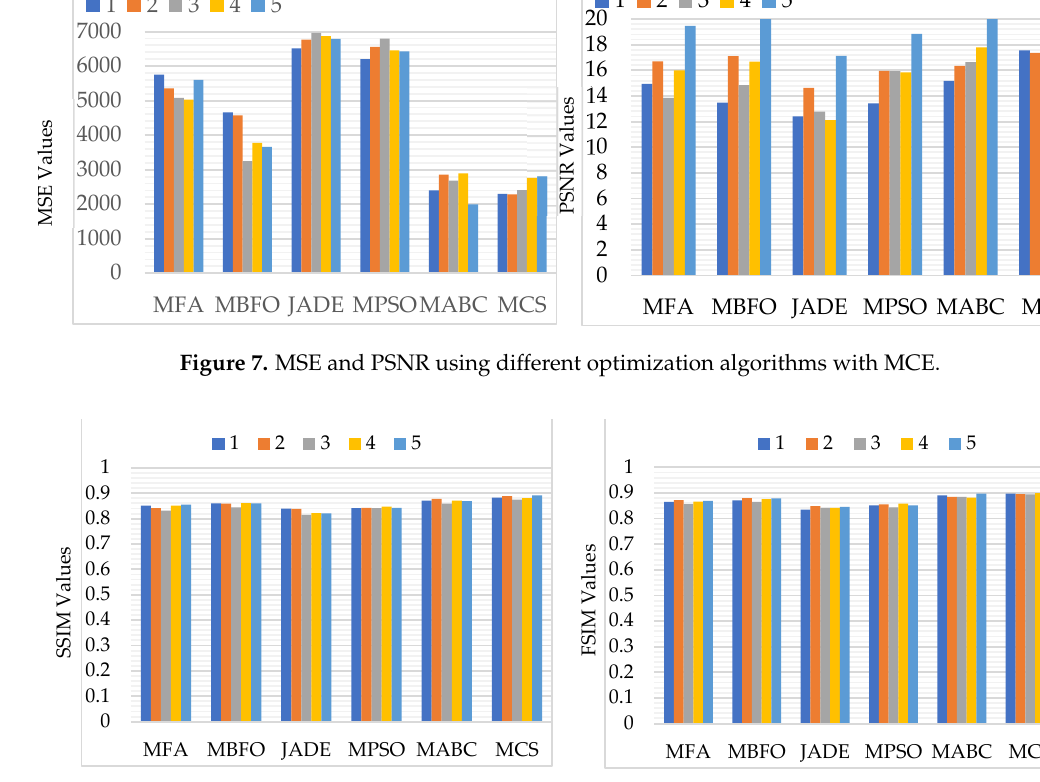
Table 6. SSIM and FSIM using different optimization algorithms with minimum cross entropy.